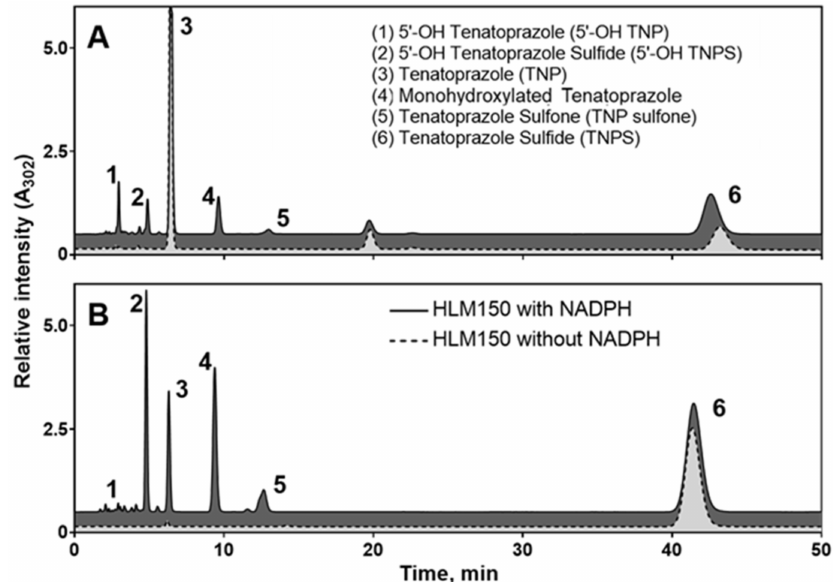
Figure 2. HPLC chromatograms of the metabolites of tenatoprazole ( A ) and tenatoprazole sulfide ( B ) produced by HLMs after a two-hour incubation. Solid and dotted lines indicate the presence and absence of NADPH,